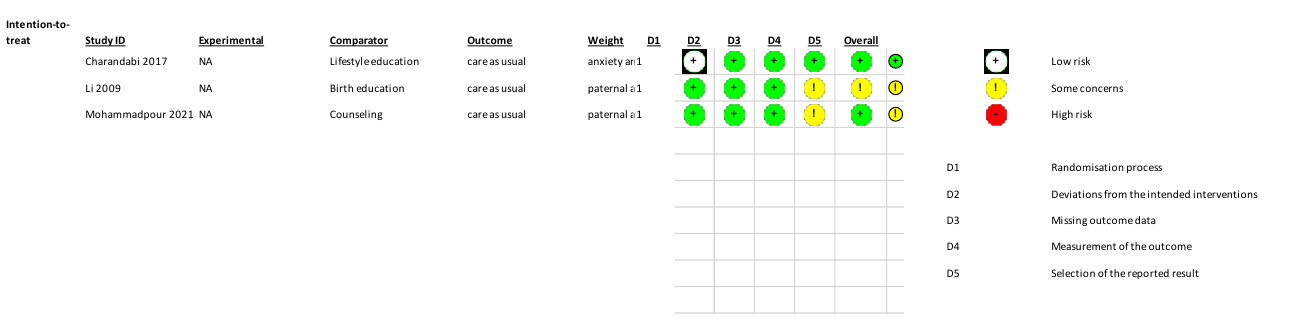
Figure 7. Risk of Bias assessments – state anxiety outcomes [38,43,46].